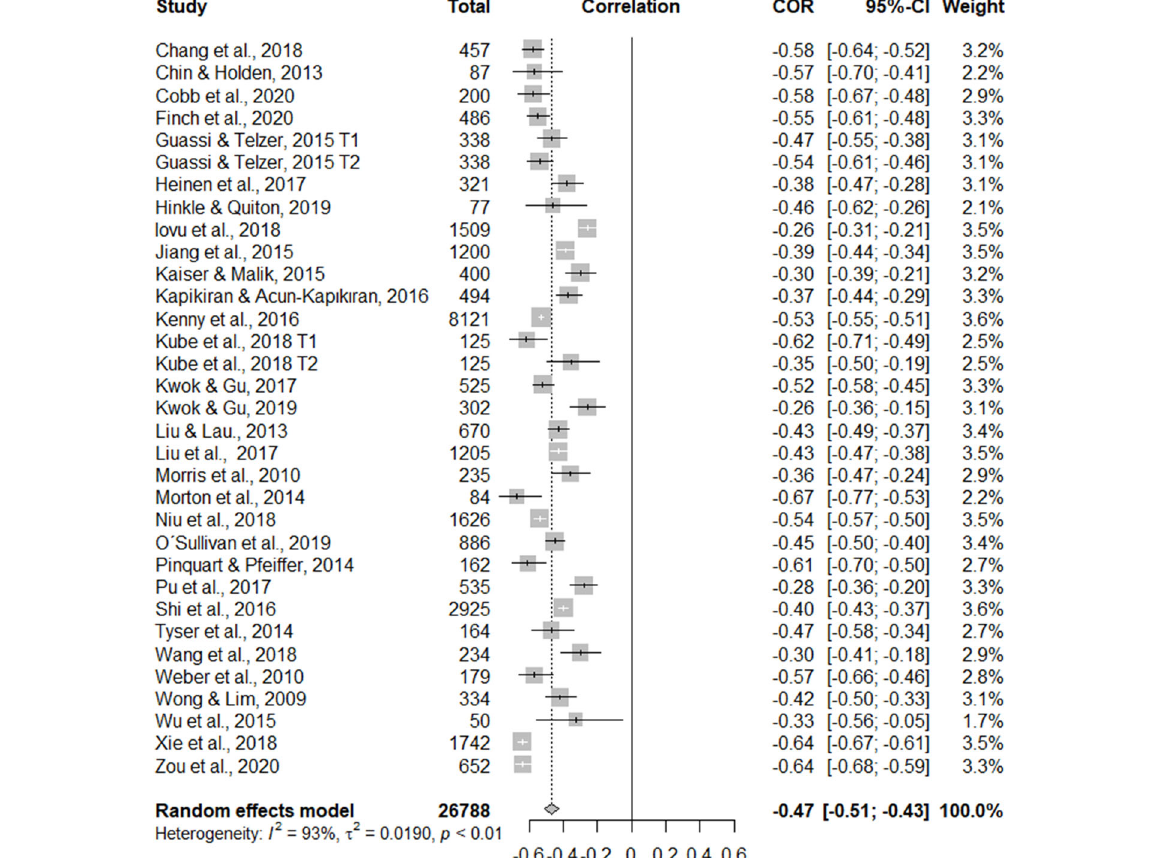
Fig. 3 Forest plot of the overall meta-analysis. The weighted effect size corresponds to the overall association between dispositional optimism and depression in young